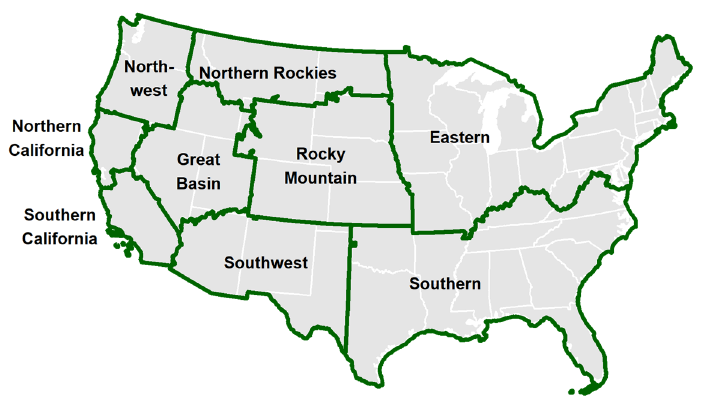
Figure 1. A map of the nine wildfire management geographic areas in the conterminous US. Hawaii is a part of the Southern California geographic area (not pictured). The tenth geographic area comprises Alaska (not pictured). Boundaries from the National Interagency Fire Center Open Data; available at https://hub.arcgis.com/datasets/nifc::national-gacc-boundaries/about, accessed 28 February 2022. Map created by Erin Belval.